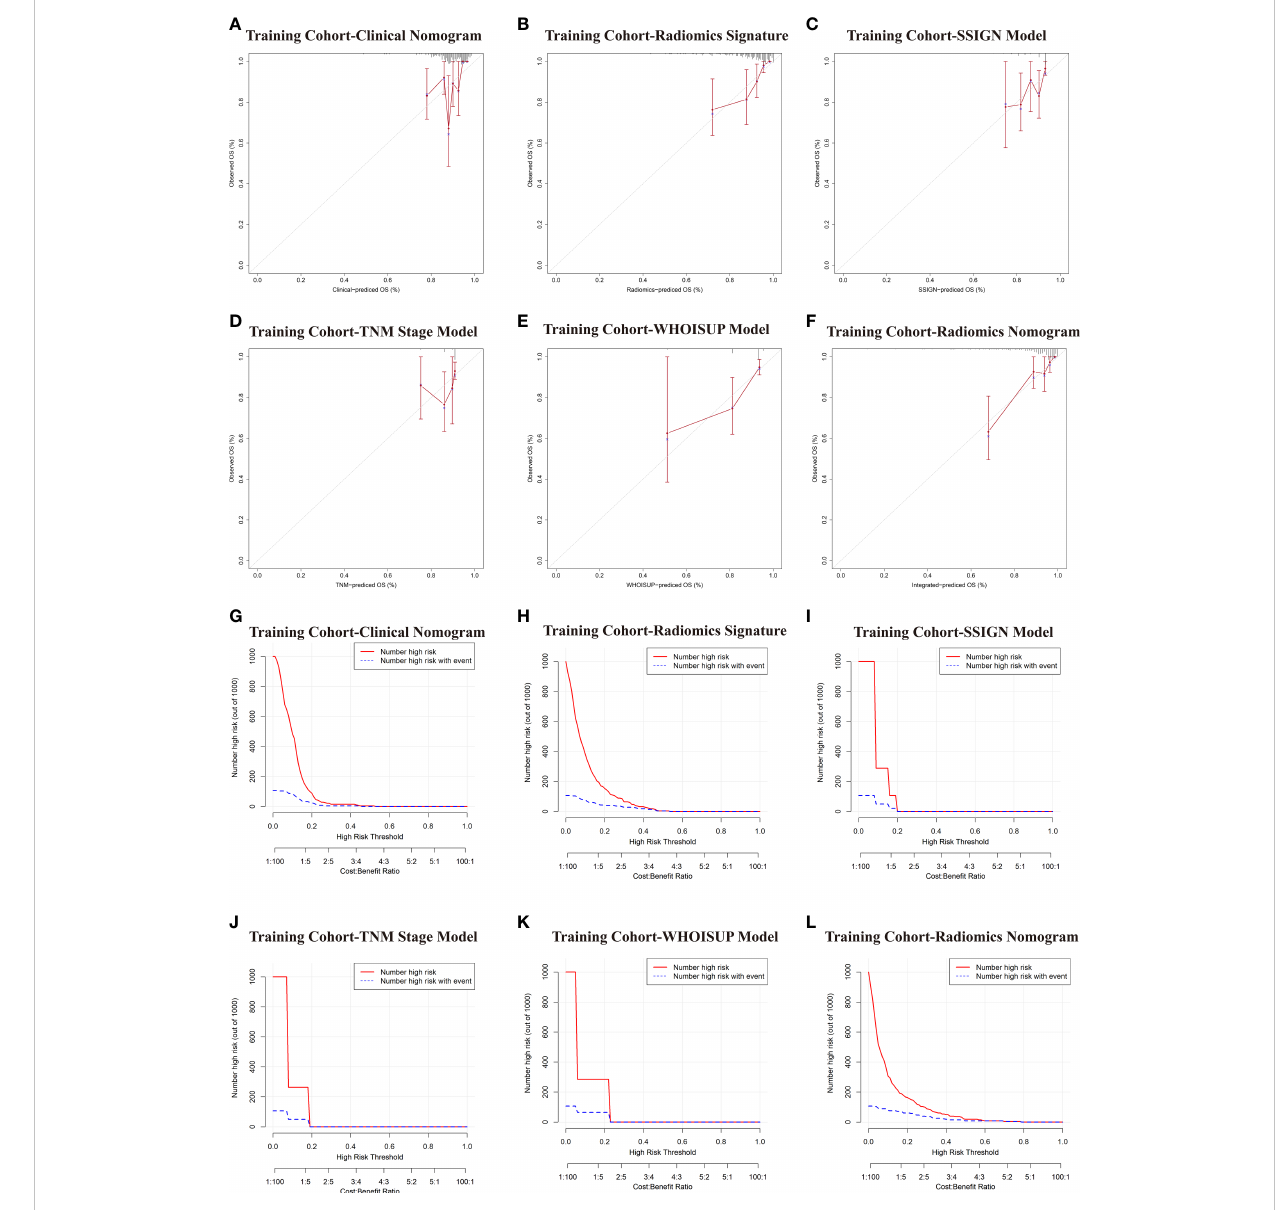
FIGURE 6 Comparative evaluation of various models in the training and validation cohorts. (A – F) Calibration plots describing the calibration of six models based on the consistency between predicted and observed 5-year OS results. (G – L) Clinical Impact Curve (CIC) of six models in the training cohort. The red curve (Number high Risk) represents the number of people classi fi ed as positive (high risk) by the model at each threshold probability; The blue curve (Number high risk with outcome) is the Number of true positives at each threshold